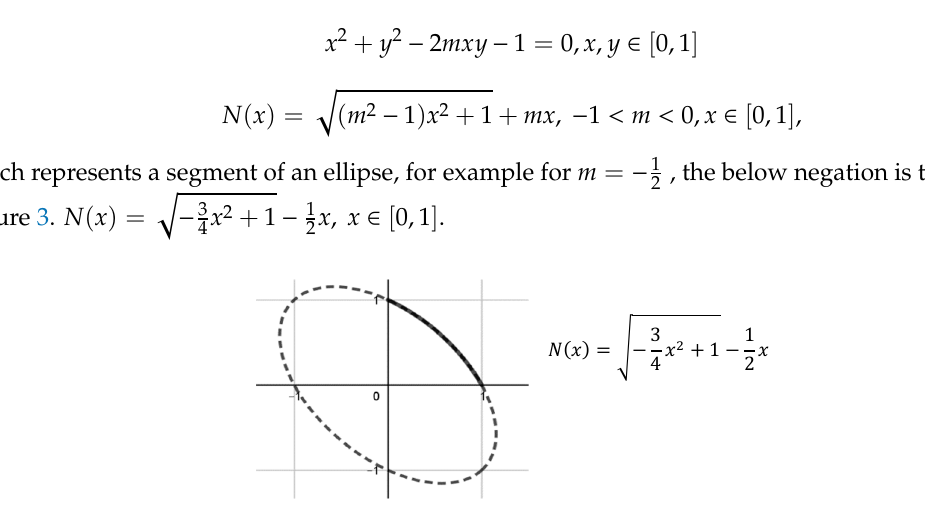
Figure 3. Conical section of ellipse: 𝑥 2 + 𝑥𝑦 + 𝑦 2 = 1 Figure 3. Conical section of ellipse: x 2 + xy + y 2 =